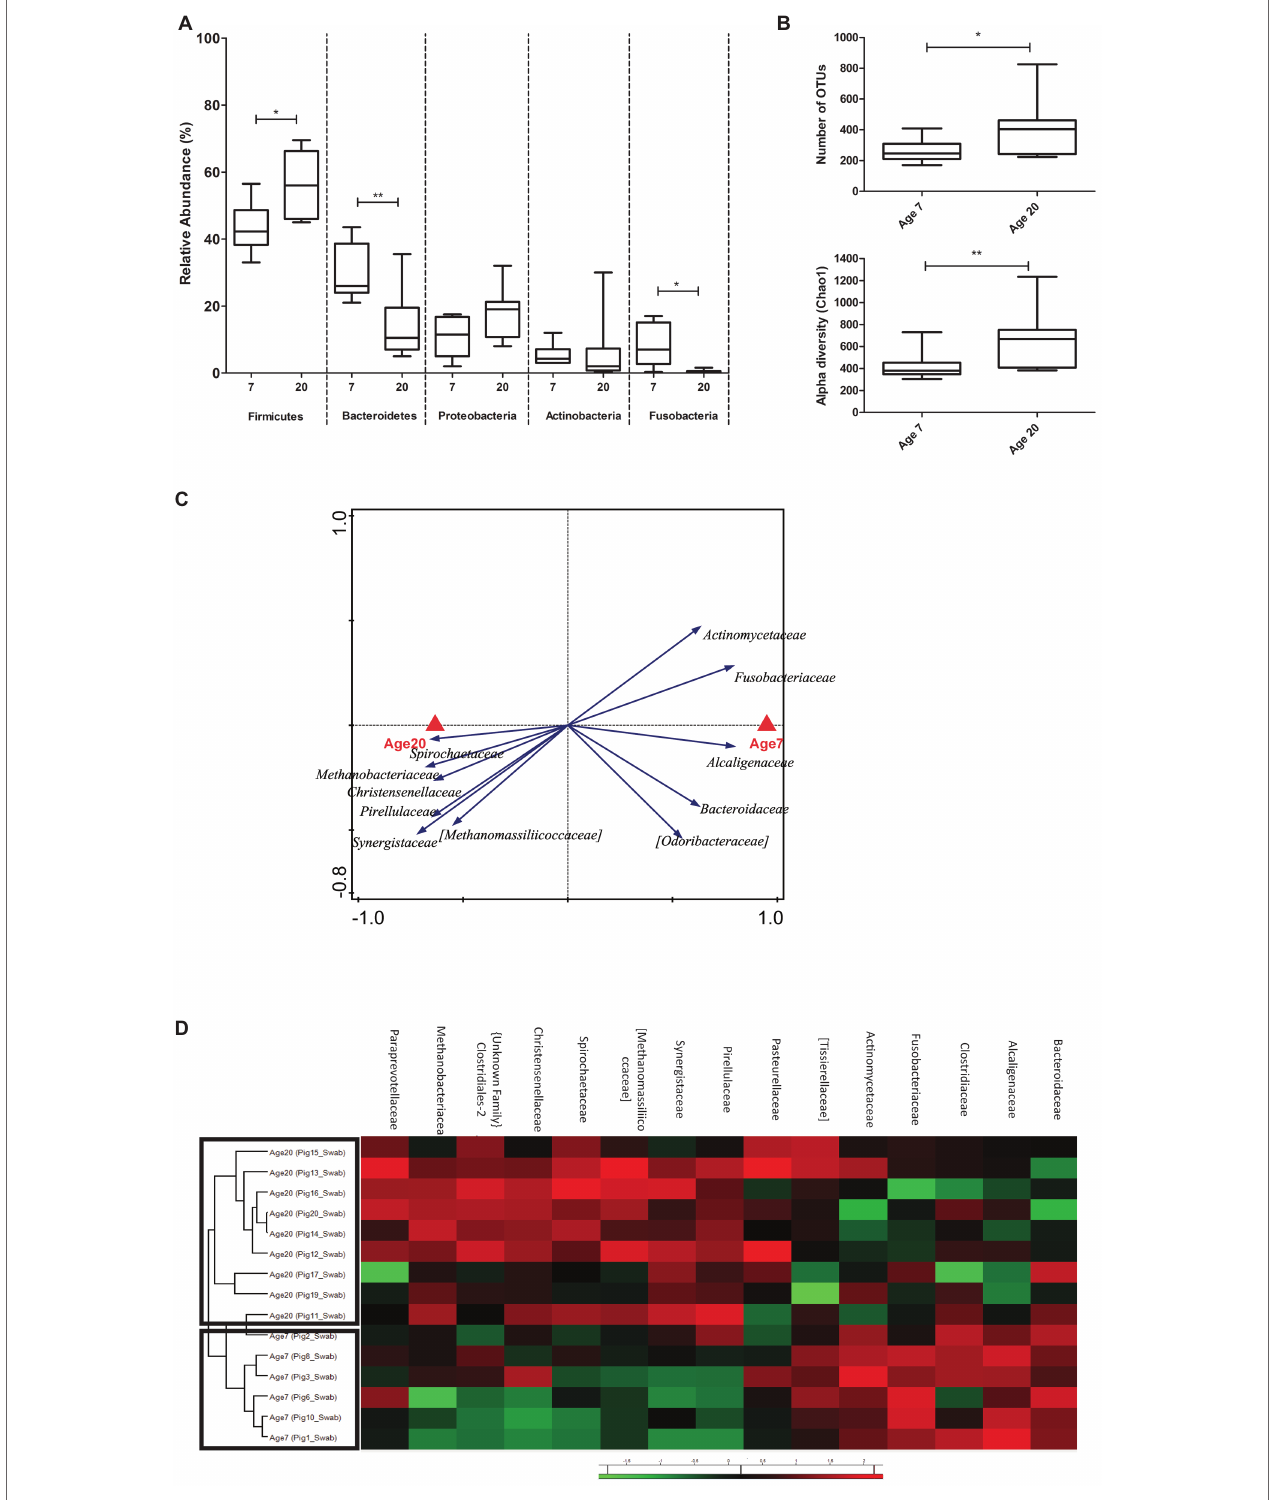
FIGURE 6 | Microbial community composition of rectal swab samples. (A) Relative abundance of five phyla (with highest relative abundance) at two ages in rectal swabs (Mann Whitney U-test, * p < 0.05, ** p < 0.01). (B) Alpha diversity (Chao1 bias corrected) display changing diversity between the two ages. (C) Redundancy analysis (partial RDA) of explanatory variable age (corrected for pen) at family level of both the swabs (RD1 = 20.05% and RD2 = 16.79%). (D) Heat map showing relative abundance of most discriminative bacterial families for age (same as fecal